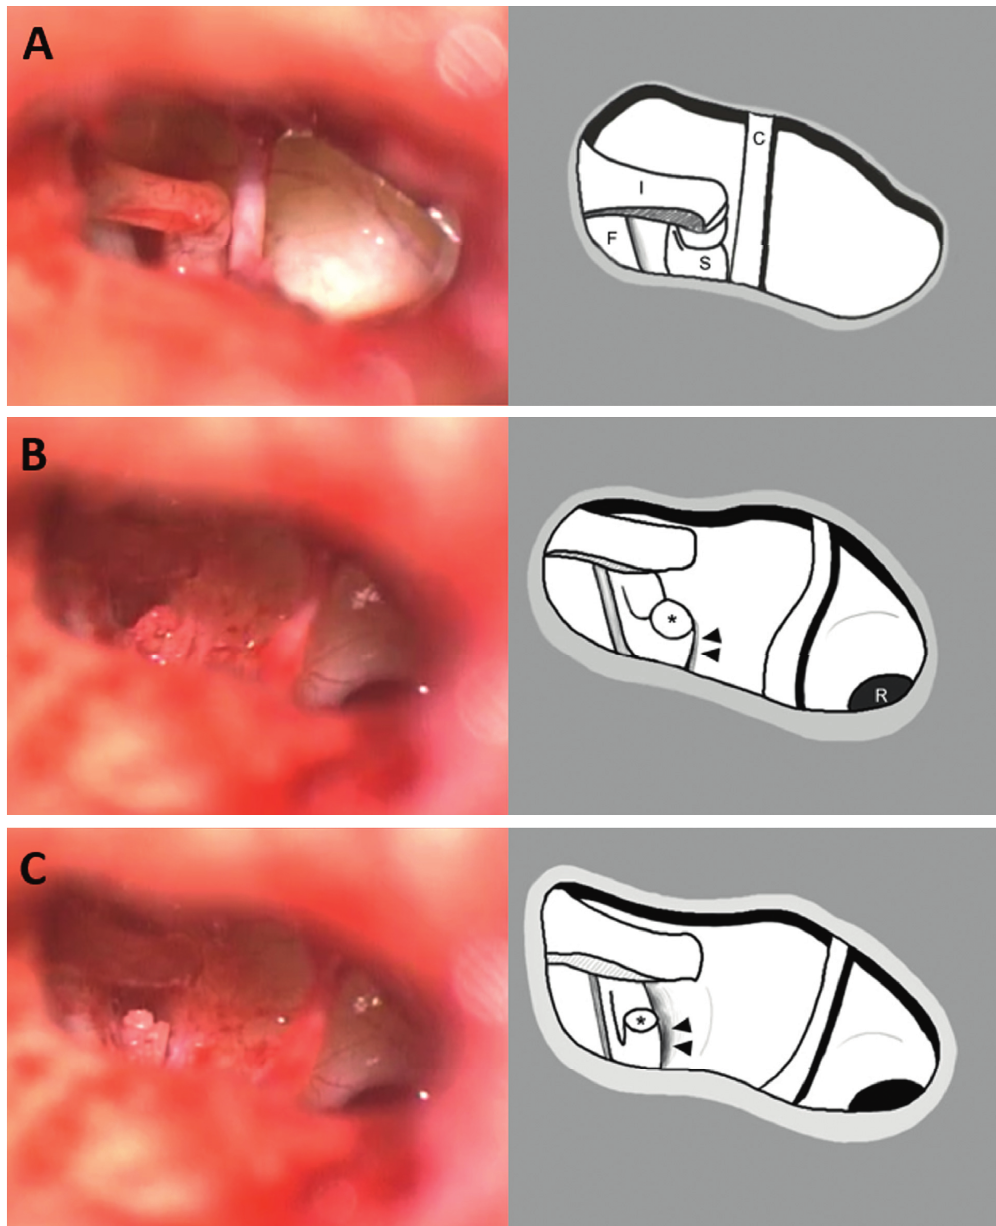
Figure 1: Operative findings. All ossicles were normally shaped (a). Part of the stapedial suprastructure was removed, and the posterior crura showed bony synostosis with the promontory ((b) arrow head). The bony synostosis was separated, and the stapedial footplate became mobile (c). I, incus; F, facial nerve; S, stapes; C, chorda tympani; R, round window; ∗ posterior crura